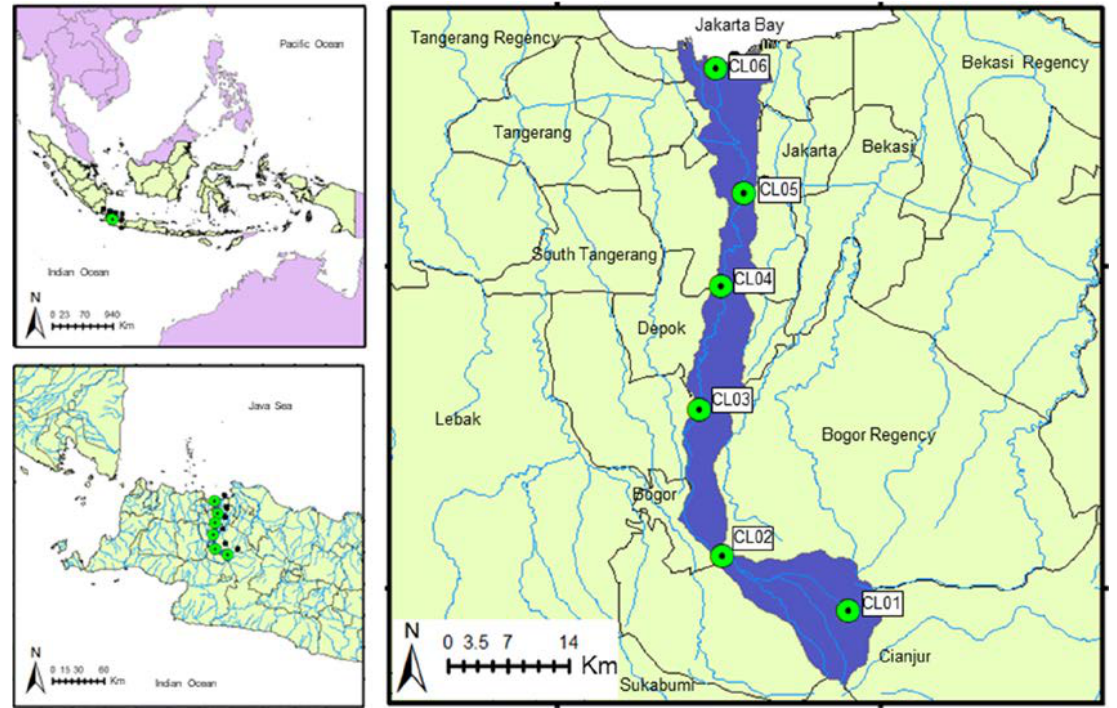
Fig. 1: Geographic location of the study area along with the sampling locations at Ciliwung River, Indonesia